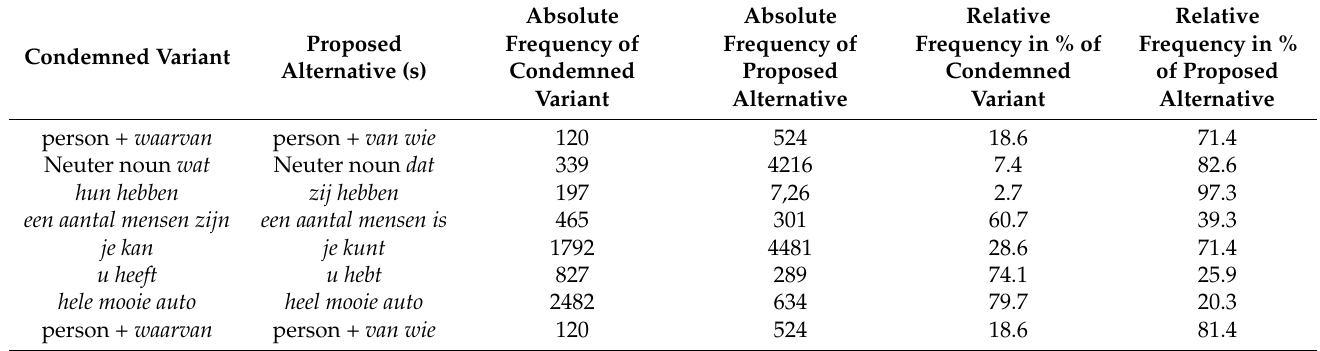
Table A4. Grammatical usage items with absolute and relative frequency counts of condemned and approved variants in